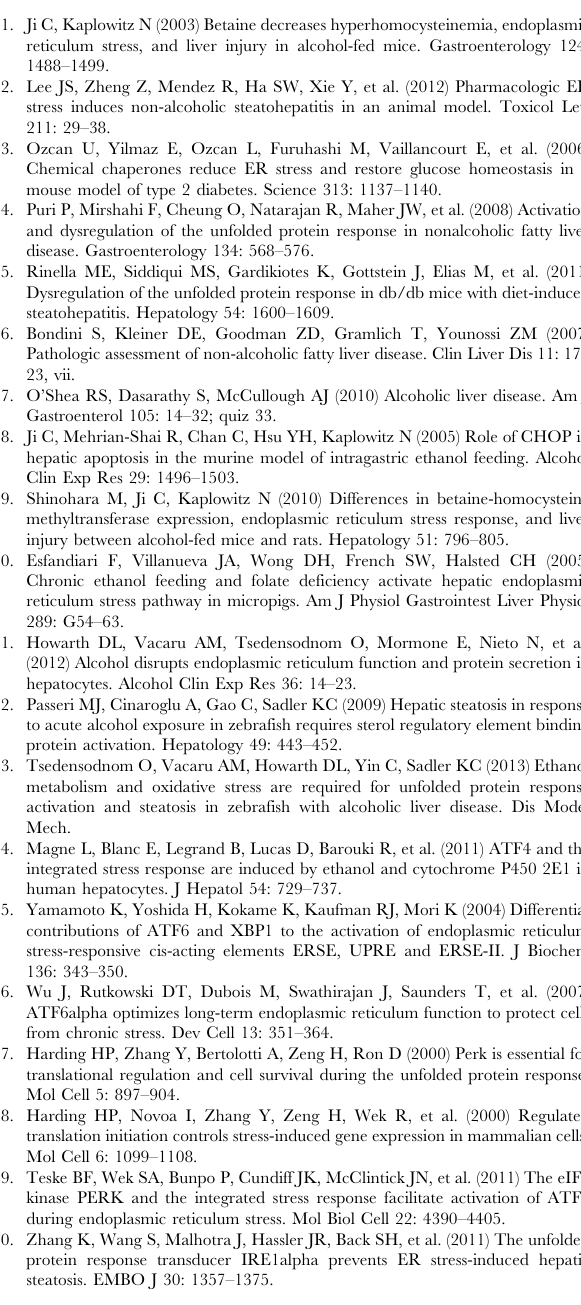
Table S4 Raw data from mRNA-Seq. Livers from 2 clutches of Tg(fabp10:nls-mCherry) expressing larvae or from 1 clutch of nAtf6 TG larvae were dissected and pooled for RNA extraction and library preparation. Genes are organized from highest to lowest log value for nAtf6 TG larvae. Text S1 Supplementary